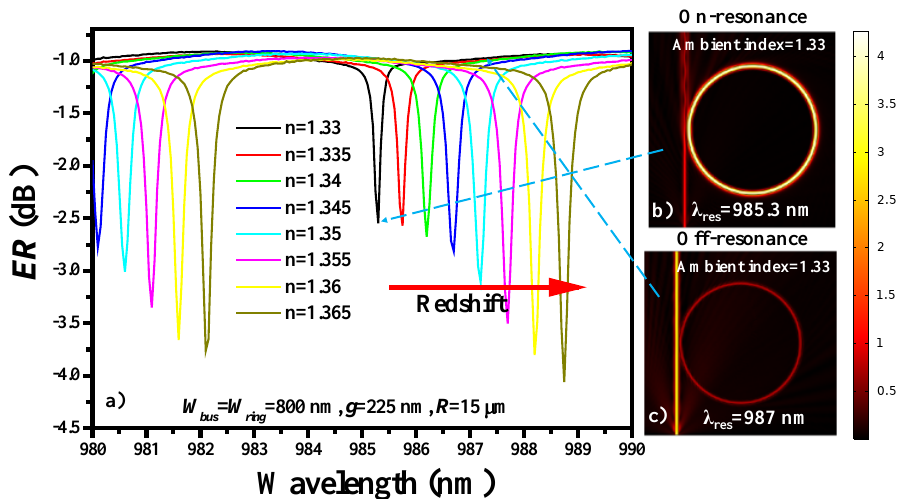
Figure 12. ( a ) Transmission spectrum of the RR structure in the presence of different ambient refractive indices. Normalized E-field distribution in the RR structure in the ( b ) on-resonance state and ( c ) off-resonance state. The geometric parameters of the structure are as follows: R = 15 µ m, g = 225 nm, and W bus = W ring = 800 nm.